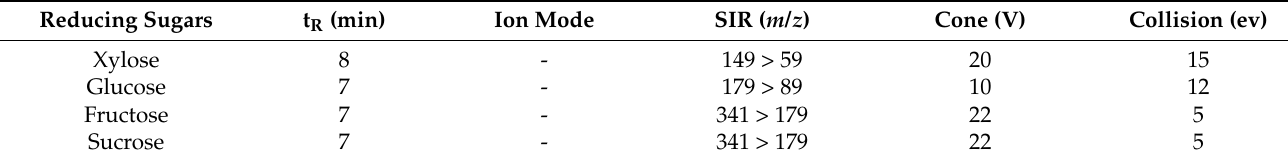
Table 5. Mass spectrometric conditions for reducing